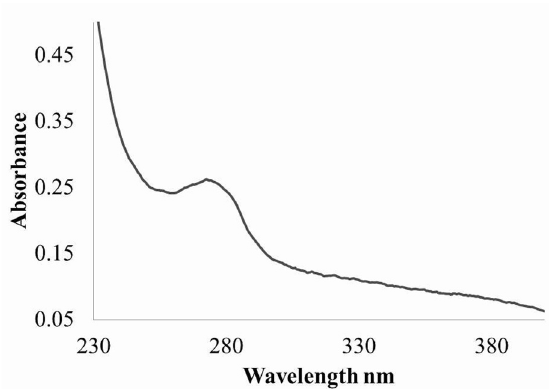
Figure 3. UV-Vis absorbance spectra from (230 nm to 400 nm) of the purified protein from Moringa oleifera leaf extract is